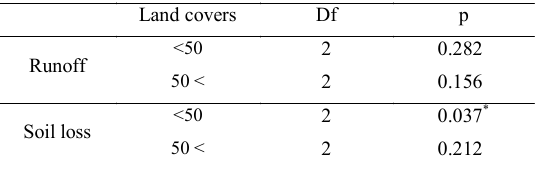
Table 8: The results of Kruskal-Wallis test on land covers and runoff and soil loss in each aspect